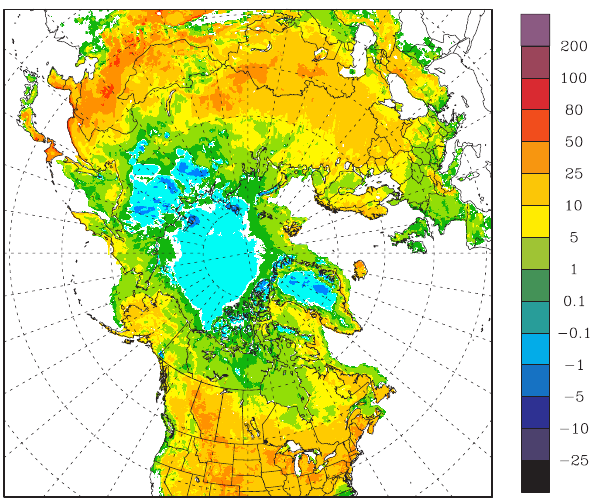
Fig. 14. Winter season surface sublimation from empirical formula over DJF 2006/2007. Units in mm